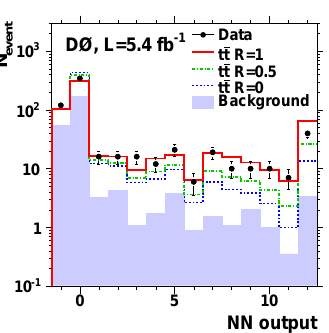
Fig. 8. Distribution of the minimum b -tag NN output of the jets of highest- p T in dilepton